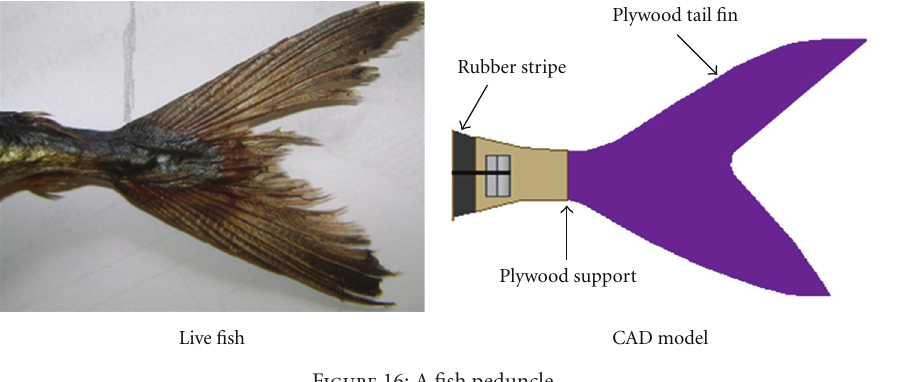
Figure 16: A fish peduncle.